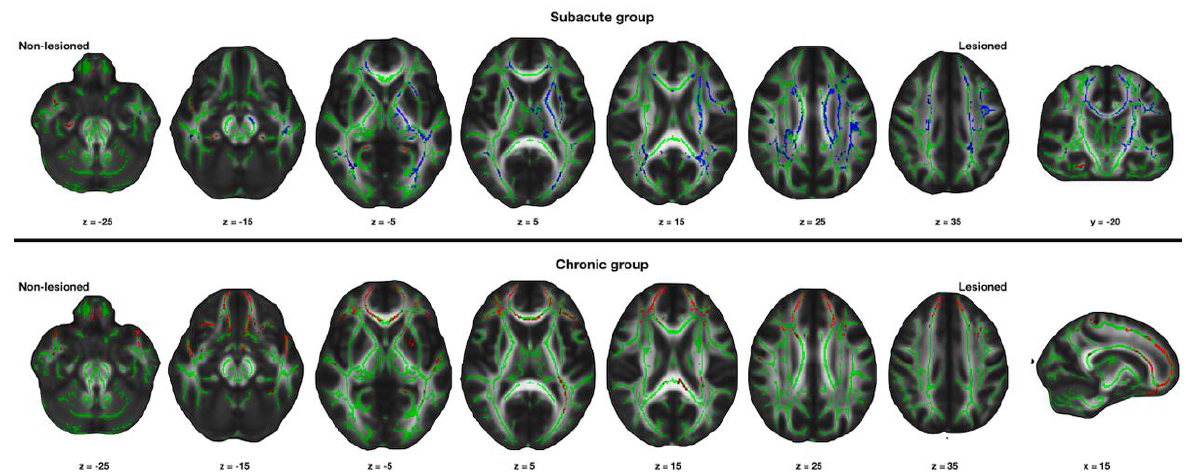
Figure 2. Results of the tract based statistical analysis. Red areas indicate increased values of fractional anisotropy in the anisotropy in the patient group compared with the age-matched control group. Blue areas indicate patient group compared with the age-matched control group. Blue areas indicate decreased values of fractional anisotropy decreased values of fractional anisotropy in the patient group compared with the age-matched control in the patient group compared with the age-matched control group. x, y, z: x-, y-, z -axis in Montreal Neurological Institute group. x, y, z: x-, y-, z -axis in Montreal Neurological Institute space. Statistical threshold: corrected space. Statistical threshold: corrected p < 0.05. p <